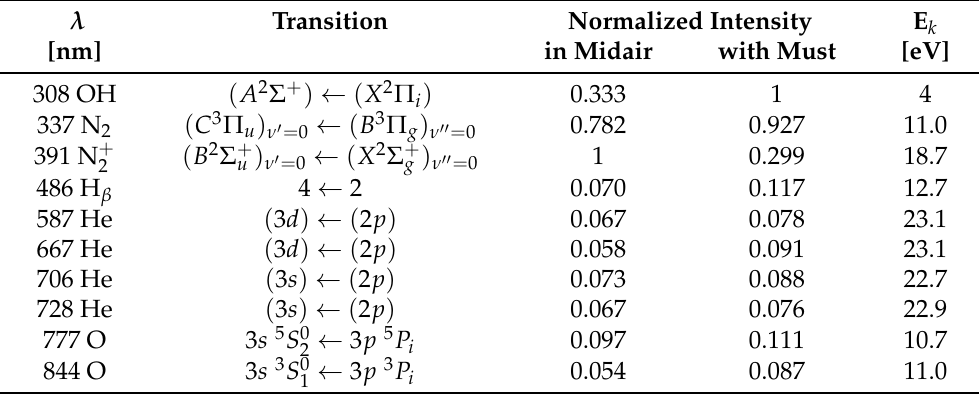
Table 2. Normalized spectral lines and bands intensity observed in the discharge with energies E k of the upper states from